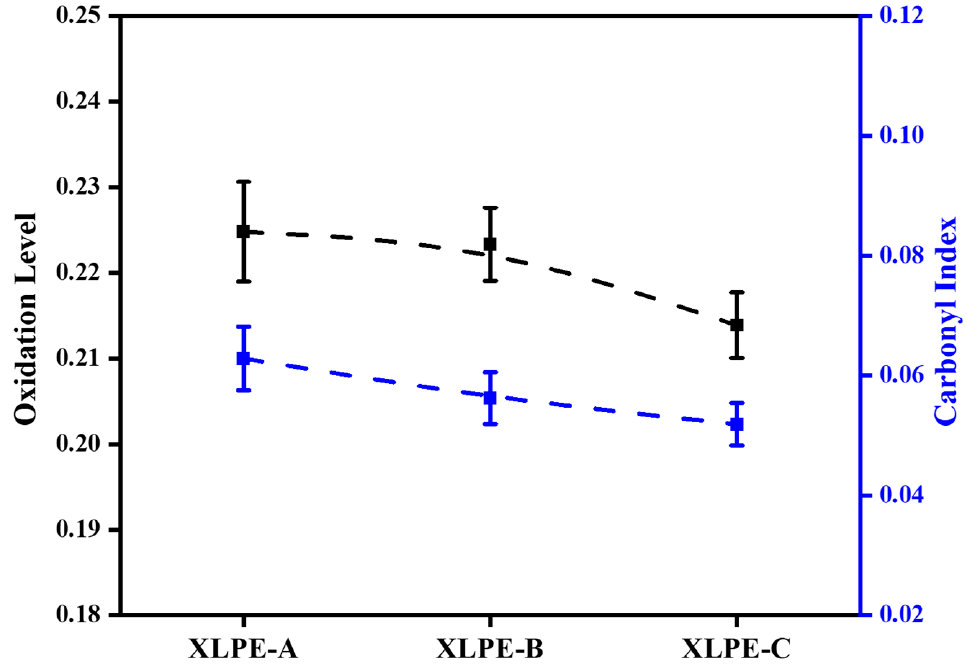
Figure 6. Oxidation level/carbonyl index for XLPE prepared with DCP content of 1.4% (XLPE-A), 1.7% (XLPE-B) and 2% (XLPE-C).